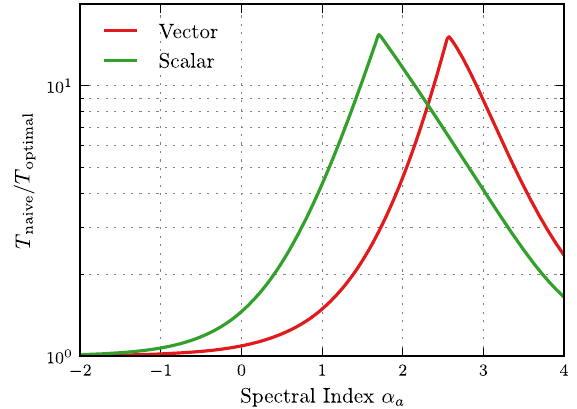
FIG. 4. The fractional increase in observing time required for Advanced LIGO to make a detection of vector (red curve) and scalar (green curve) backgrounds using existing search tech- niques, as a function of their spectral index α a . The sharp kinks in each curve are due to biases incurred when fitting vector and scalar backgrounds with a purely tensor model; see the text for